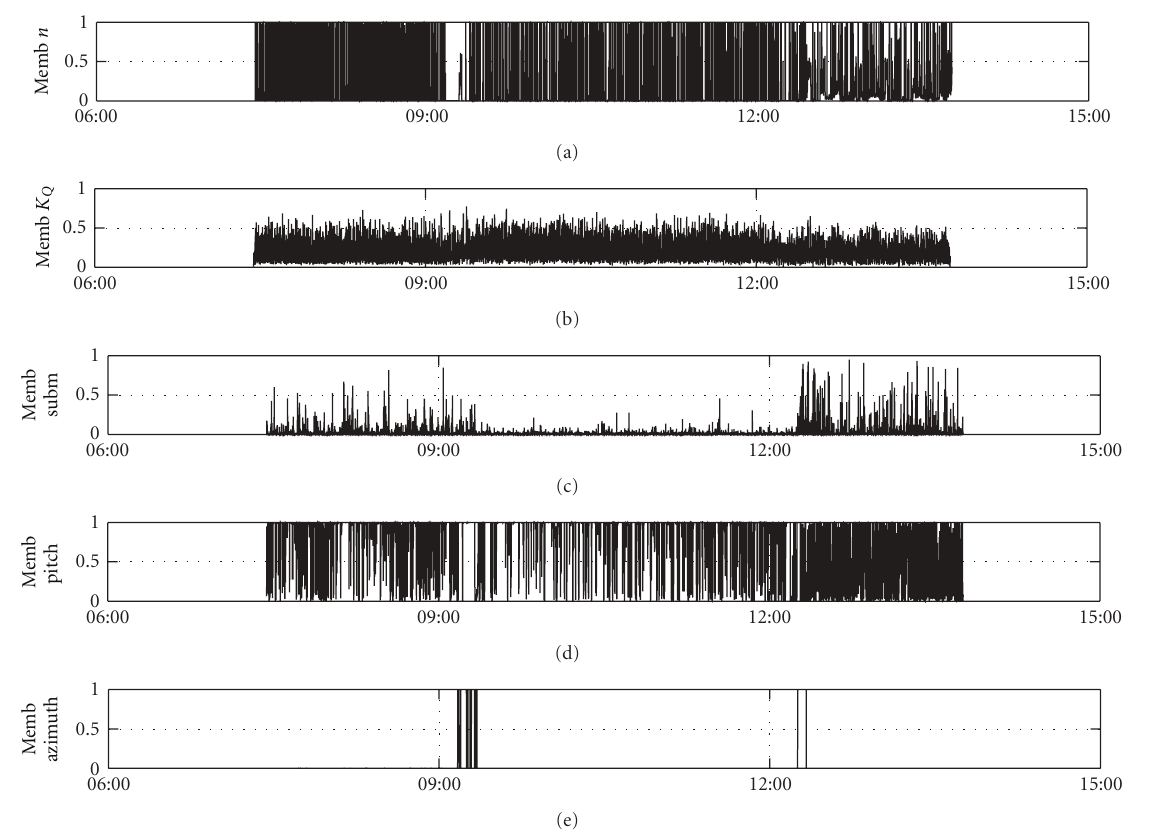
Figure 11: Membership functions during dynamic positioning